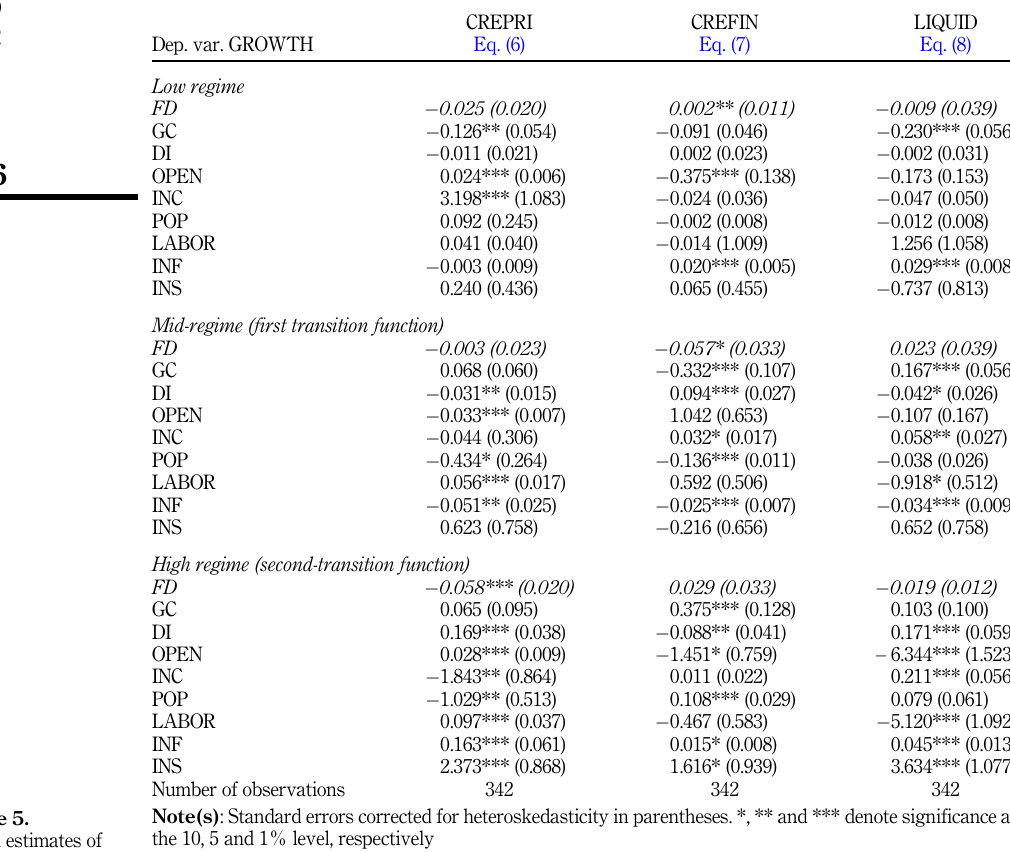
Table 5. PSTR estimates of explanatory